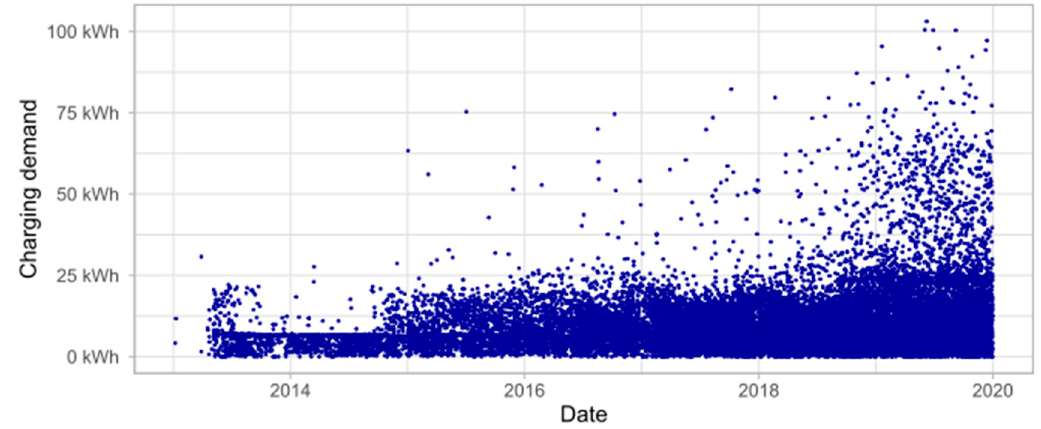
Figure 2. Charging demand for every session.